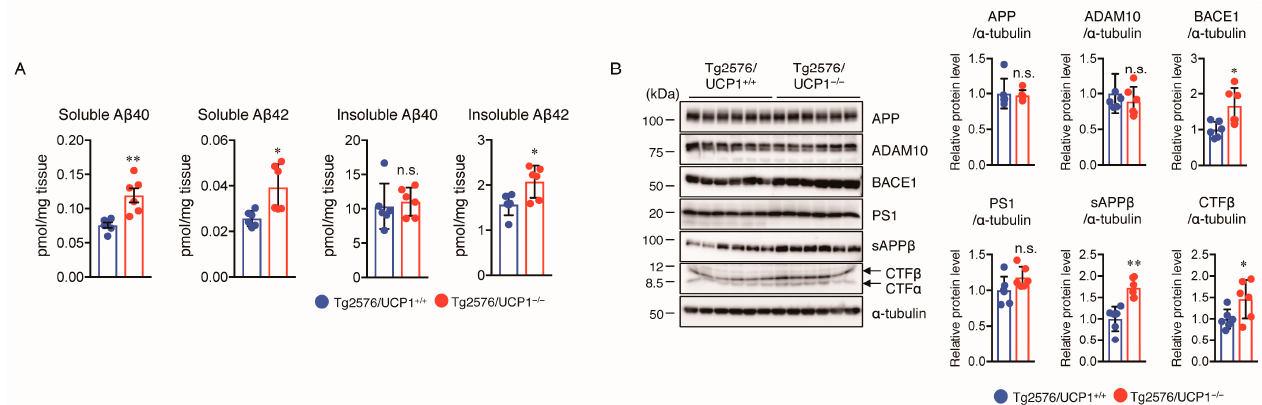
Figure 2. UCP1 deletion in Tg2576 mice increases BACE1 level leading to an increase in A β levels in the cortex of brain. ( A ) The levels of soluble and insoluble A β 40 and A β 42 in the cortex of brain of 17-month-old mice were measured by sandwich A β ELISA. (( B ), left panel) Representative immunoblots showing the cortical levels of APP, ADAM10, BACE1, PS1, sAPP β , CTF β , and α -tubulin in Tg2576/UCP1 +/+ and Tg2576/UCP1 -/- mice. (( B ), right panels) Relative protein levels quantified by densitometry. The results shown are mean ± SD, n = 6 for each group, * p < 0.05, ** p < 0.01, vs. Tg2576/UCP1 +/+ , n.s., no significant difference, as determined by Student’s t -test. 2.3. Effect of UCP1 Deletion in Tg2576 Mice on A β Degradation and Clearance We observed that insoluble A β 40 levels were not different between Tg2576/UCP1 +/+ and Tg2576/UCP1 − / − mice; whereas, insoluble A β 42 levels were significantly higher in the cortex of Tg2576/UCP1 − / − mice than in Tg2576/UCP1 +/+ mice. Thus, we hypothesized that the high body temperature observed in Tg2576/UCP1 − / − mice may be involved